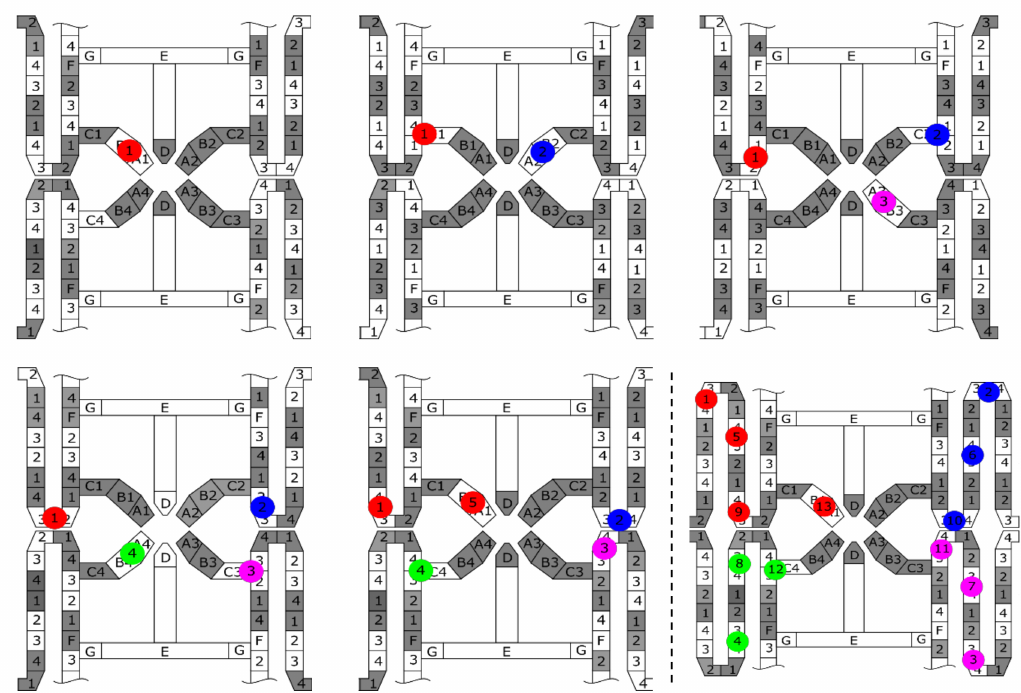
Figure 3. The pipeline operation of the combination of four collection gates and four-phase